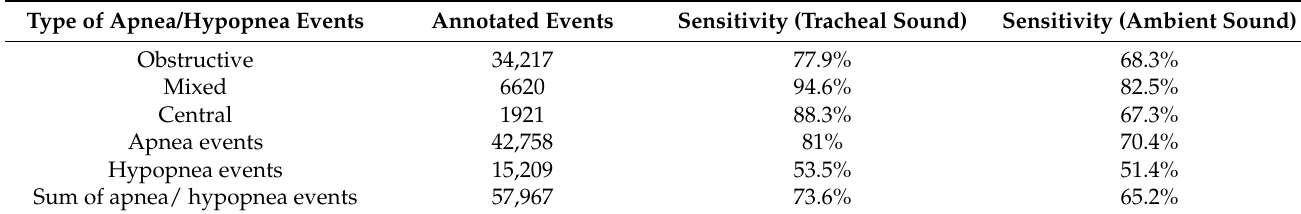
Table 2. The sensitivity exhibited by the system for apnea/hypopnea events detected for all subcategories of apneic events, based on tracheal and ambient sound